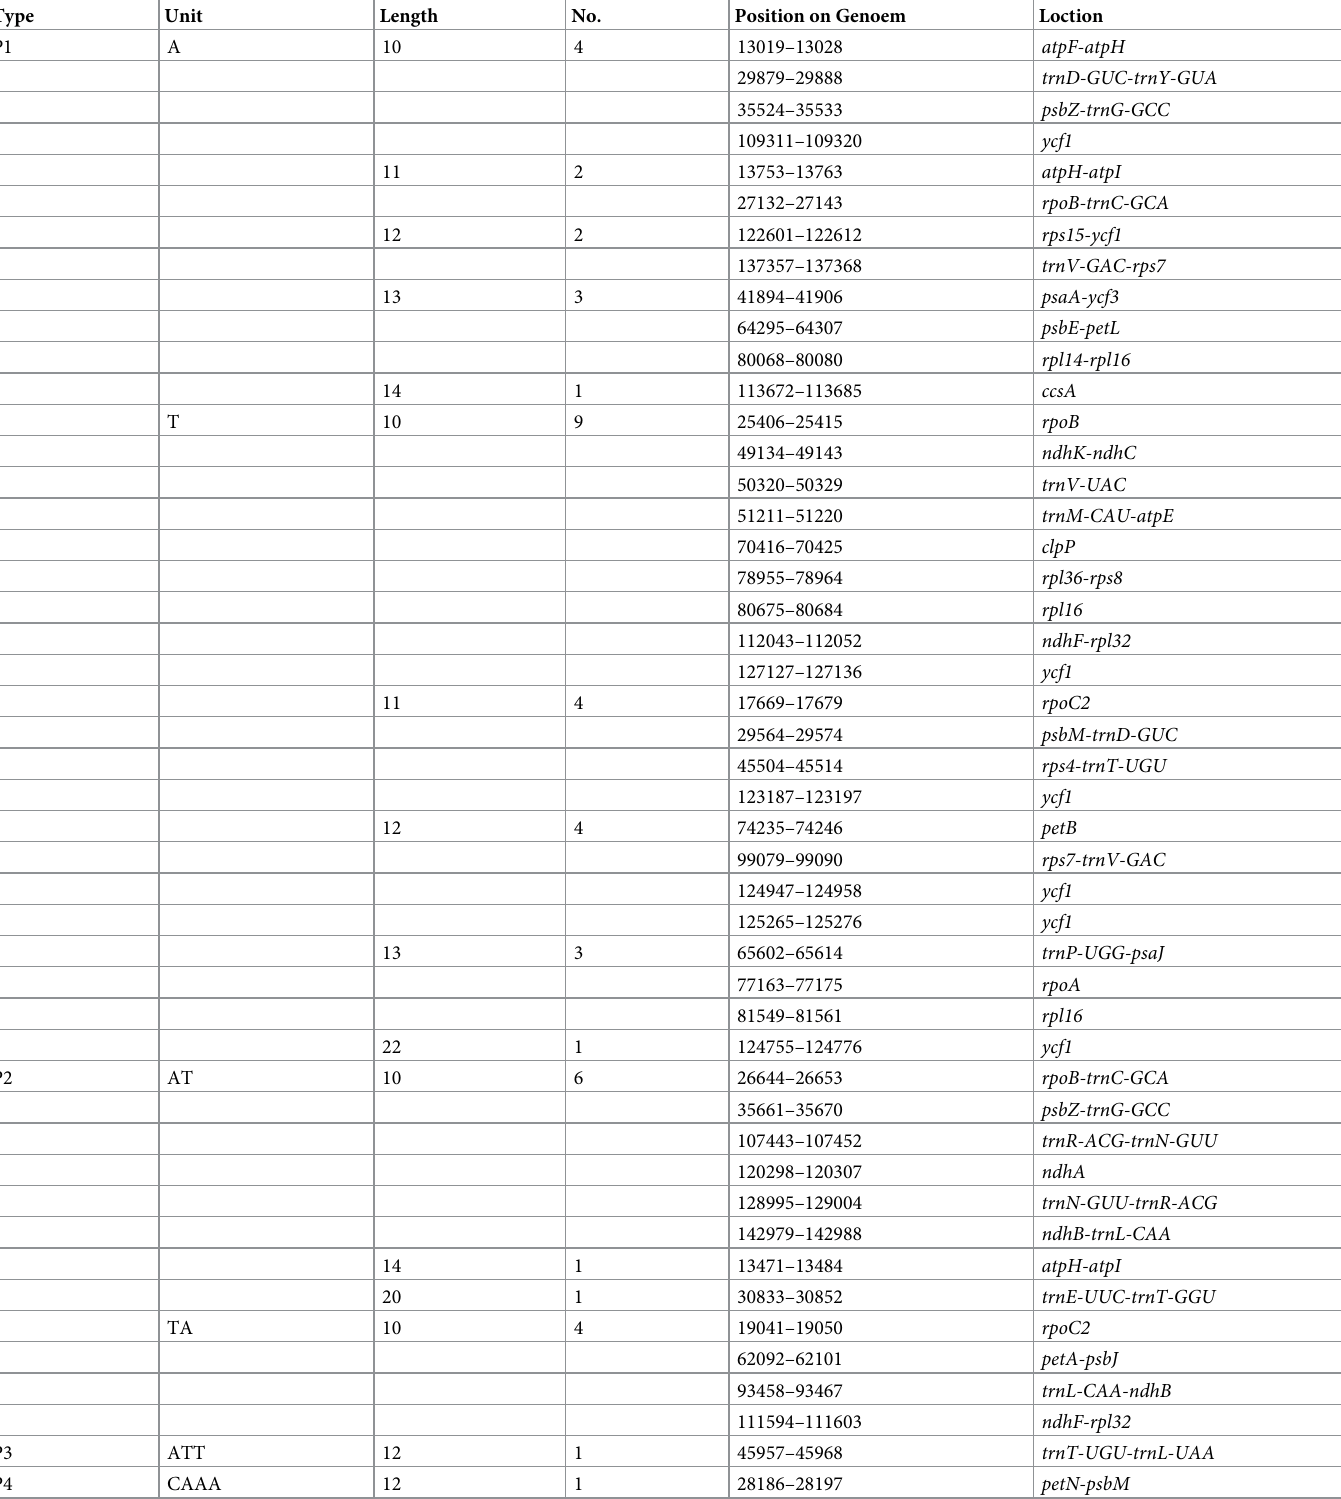
Table 4. Distribution of SSRs in the Moricandia arvensis cp